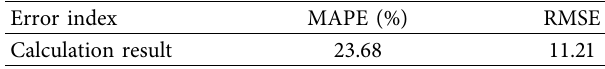
Table 3: Error calculation